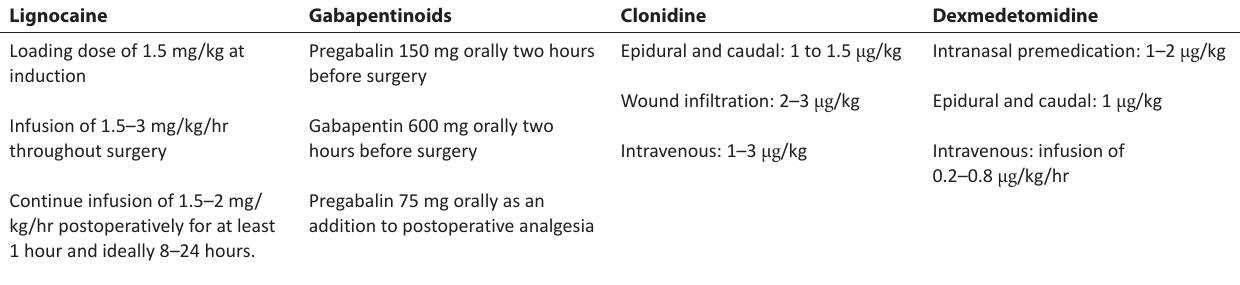
Table 1. Summary of suggested doses of non-opioid